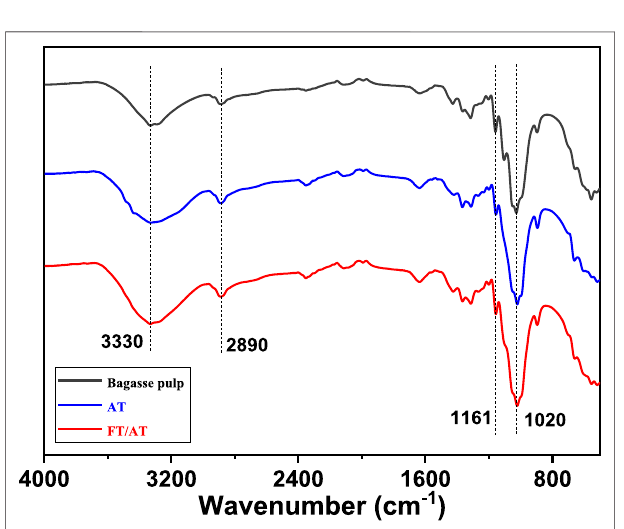
FIGURE 7 | XRD of bagasse fi ber with different